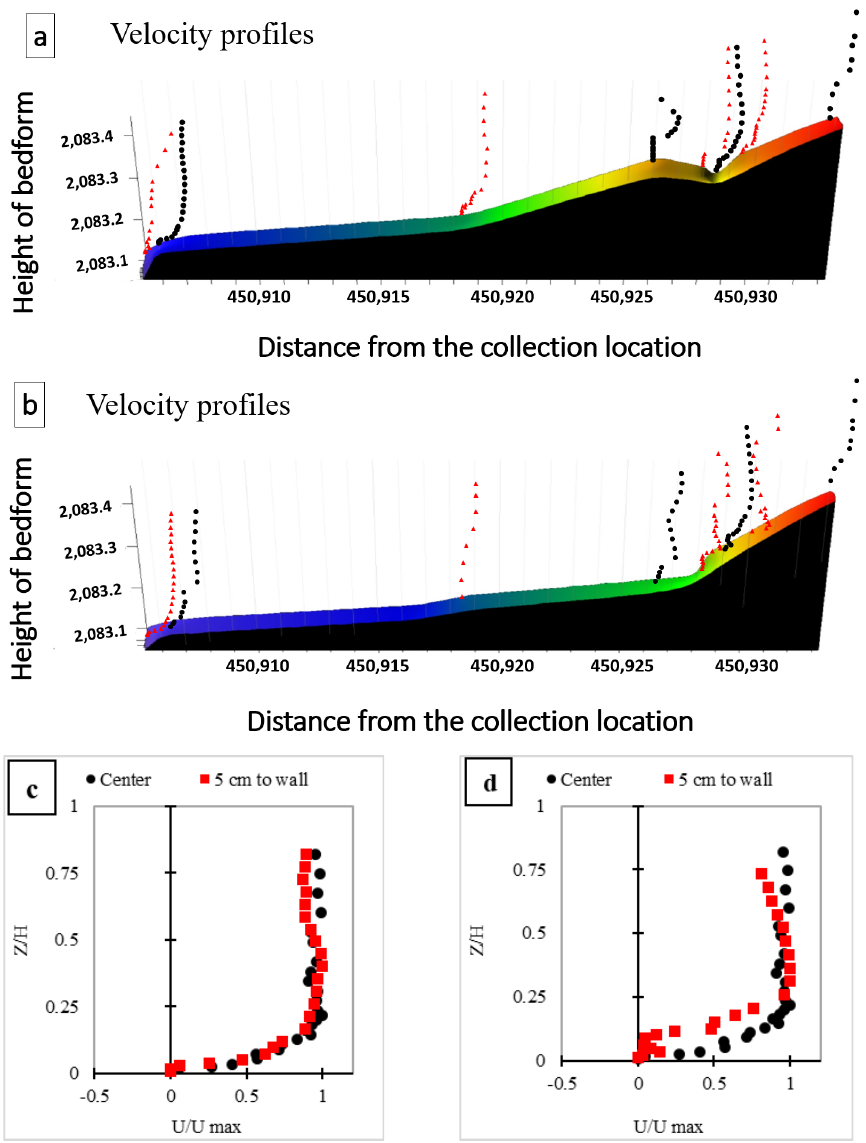
Figure 6. ( a ) Nondimensional velocity profiles ( u ) in the longitudinal direction and at 5 cm of the u max left bank of the river, ( b ) nondimensional velocity profiles in the central axis of the river, ( c ) velocity profiles for the pool entrance (CS3), and ( d ) velocity profiles for riffle area in the central and 5 cm from the riverbank (CS4).